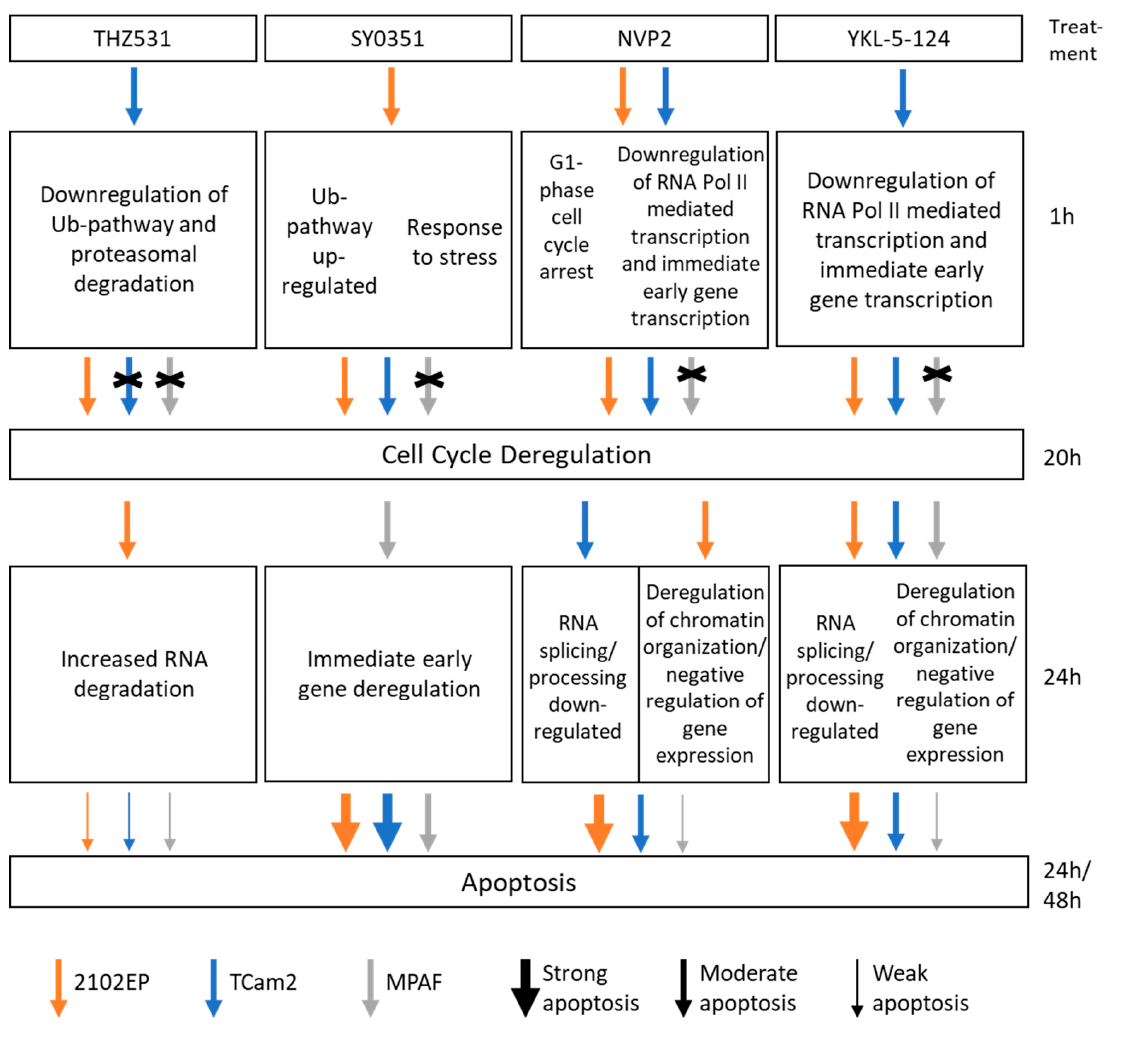
Figure 9. Schematic summary of effects in TGCT and fibroblast cell lines induced by CDK inhibitor treatment. Treatment with SY0351, NVP2 and YKL-5-124 results in cell cycle deregulation and apoptosis in TGCT cells while exposure to THZ531 is less toxic to all cell lines.